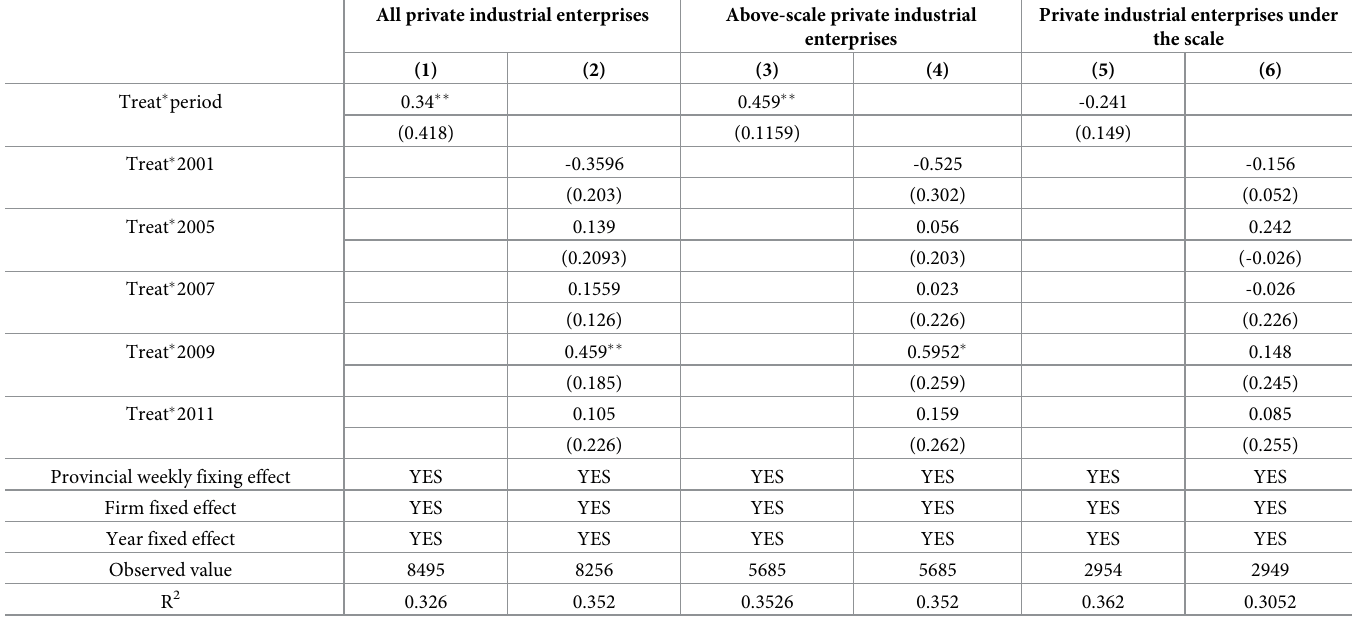
Table 5. Test of the impact on innovation inputs of private industrial enterprises and their dynamic